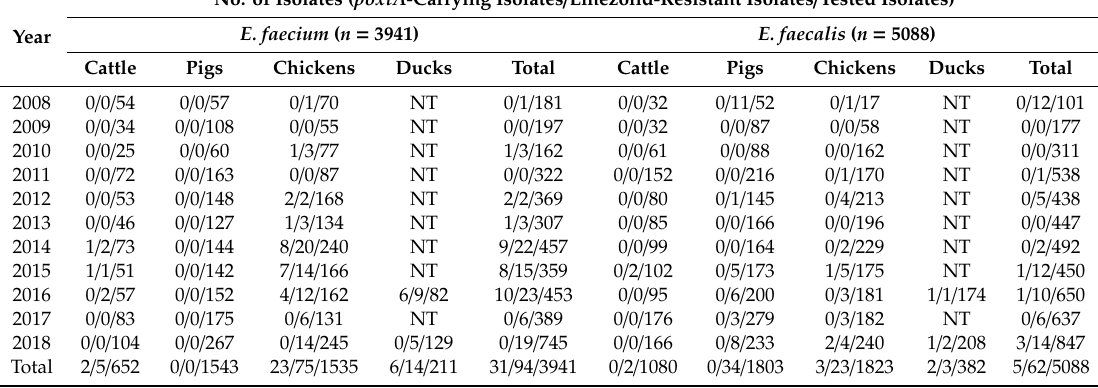
Table 1. Distribution of poxtA -carrying Enterococcus faecium and E. faecalis obtained from food-producing animals during 2008–2018 in South Korea. No. of Isolates ( poxtA -Carrying Isolates / Linezolid-Resistant Isolates / Tested Year